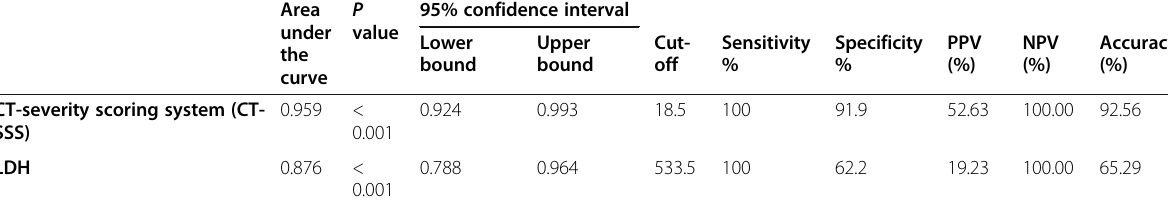
Table 5 ROC curve cut-off value for COVID-19 mortality using CT-SSS and LDH